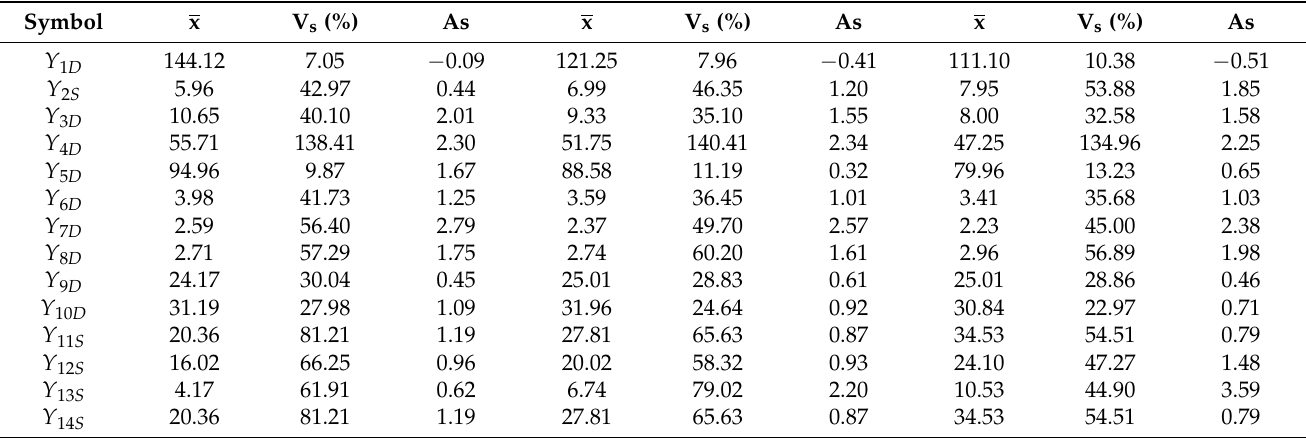
Table 2. Selected descriptive characteristics of indicators adopted for the study in years 2010, 2015, and